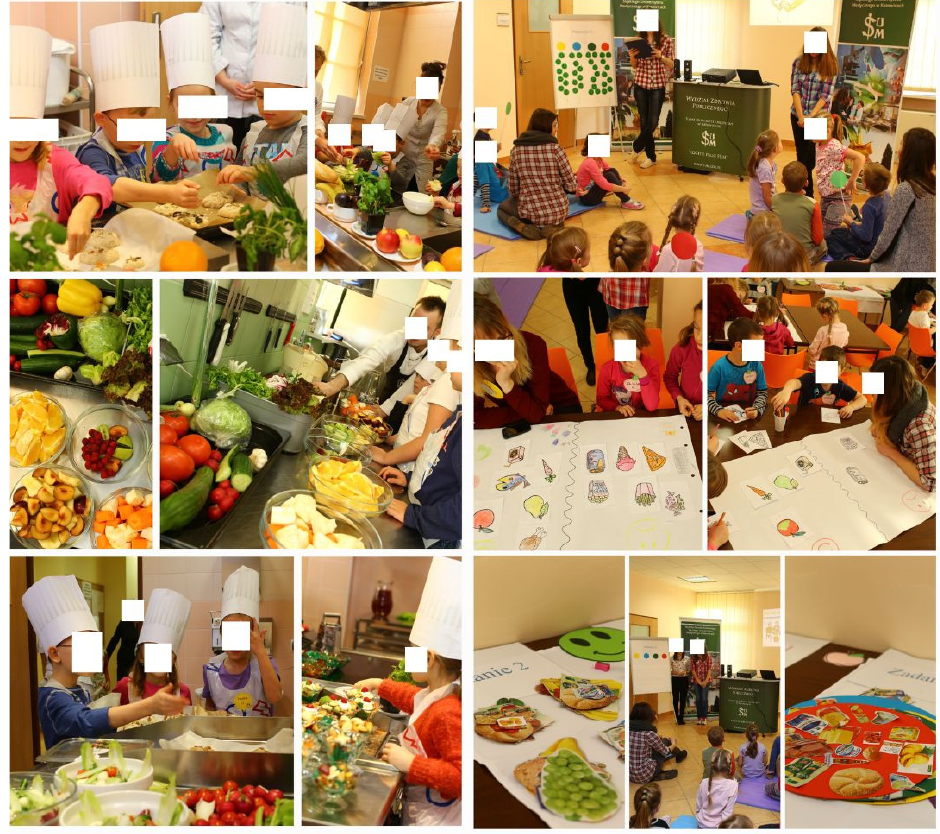
Figure 1. Educational workshops (MODULE 1) and cooking workshops (MODULE 3). (Photos by A.Bia ł ek-Dratwa).